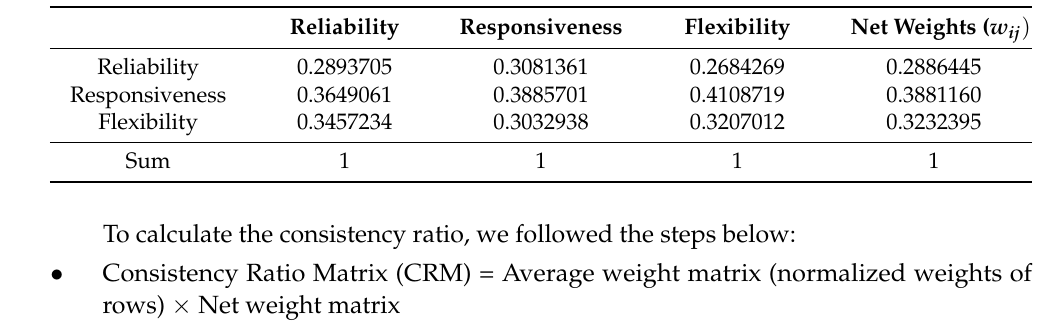
Table A3. Normalized pairwise comparison matrix.